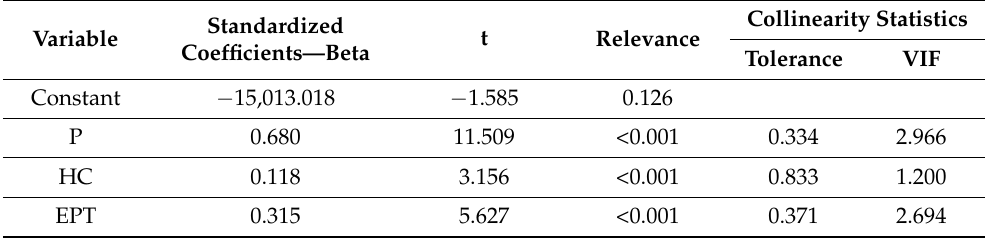
Table 9. Coefficients in the regression model of greenhouse gas emissions in 2014.